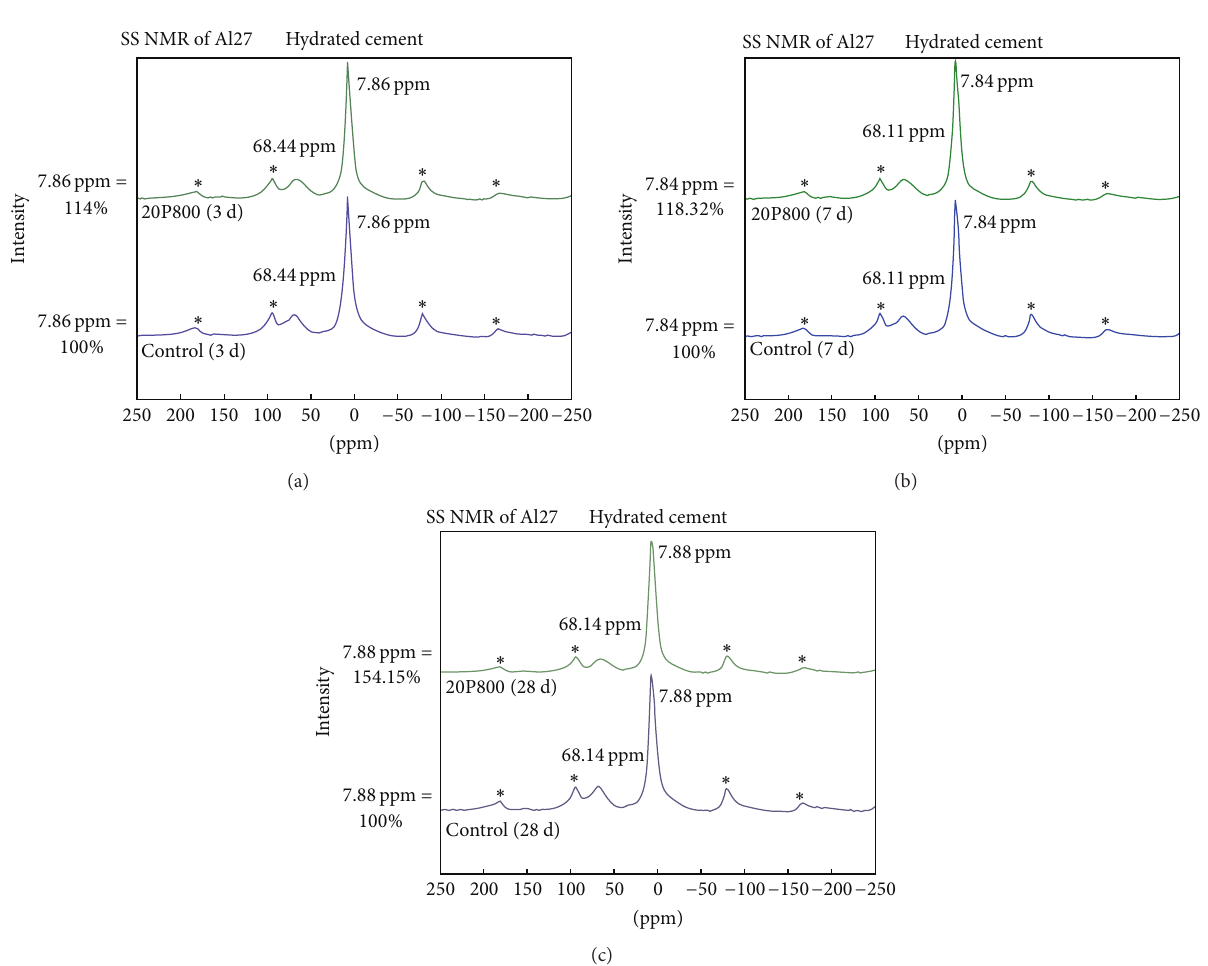
Figure 3: 27 Al MAS NMR spectroscopy of hydrated cement and cement/calcined clay paste. ∗ Noise made during